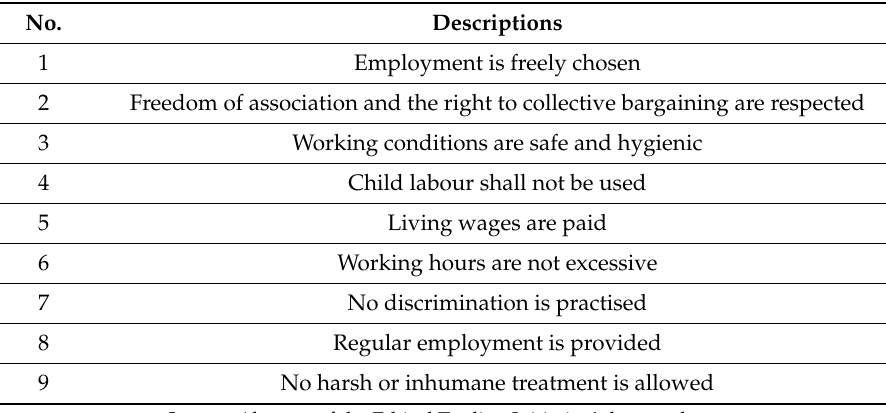
Table 1. A typical supply chain Codes of Conduct